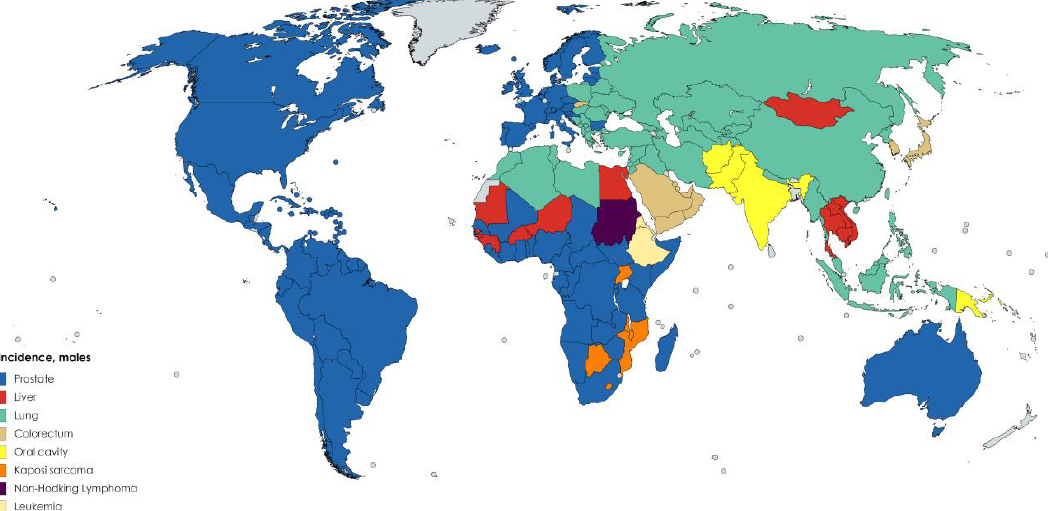
Figure 7. Worldwide cancer incidence by type in females [2]. Created with mapchart.net. Regarding breast cancer (Table 10), in the European Prospective Investigation into Cancer and Nutrition (EPIC) study, flavonoid dietary intake and breast cancer risk were analysed in a cohort of 334,850 women with an 11.5 year follow up [91]. Within this cohort were 11,576 breast cancer cases. However, there was no statistically significant association between total flavonoid (Hazard Ratio (HR) 0.97, 95% Confidence Interval (CI): 0.90–1.07) and isoflavone (HR 1, 95%CI: 0.91–1.10) intakes and breast cancer risk [91]. Another prospective study evaluated coffee and tea intake and its relationship with breast cancer risk in black women [92]. The results showed that among the 52.062 participants, there were 1268 incident cases of breast cancer during 12 years of follow up. The data showed that that the intake of coffee (Internal Rate of Return (IRR): 1.03, 95% CI: 0.77–1.39) or tea (IRR: 1.13, 95% CI: 0.78–1.63) was not associated with the risk of breast cancer [92]. Regarding tea and coffee intake, a study performed in Sweden suggested that tea intake is positively associated with oestrogen and progesterone receptor-positive breast cancer, but that coffee consumption is negatively associated with the risk of oestrogen receptor-positive, progesterone receptor-negative breast cancer [93]. Another study performed in Shanghai attempted to associate urinary polyphenols with breast cancer risk [94]. They measured tea flavonols (kaempferol and quercetin) and polyphenols as epicatechin in a cohort with 353 cases and 701 controls. They observed an inverse